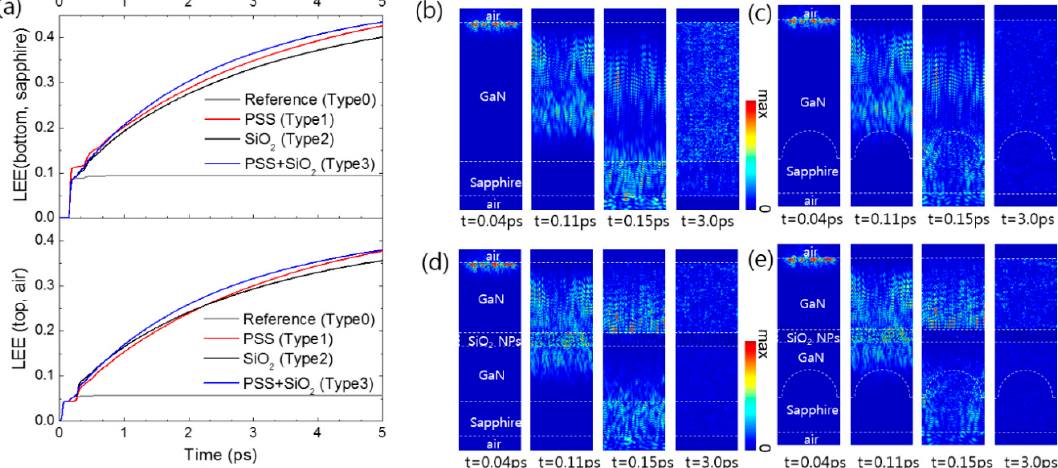
Figure 4. (Simulation data) ( a ) Top and bottom direction light extraction efficiency (LEE) of four types as a function of time after source excitation. ( b – e ) Cut-views of intensity distributions of the electric field at different times after source excitations shown at the bottom. ( b ) Reference ( c ) PSS ( d ) SiO 2 , and ( e ) PSS + SiO 2 . The dotted lines indicate the boundary of the materials.